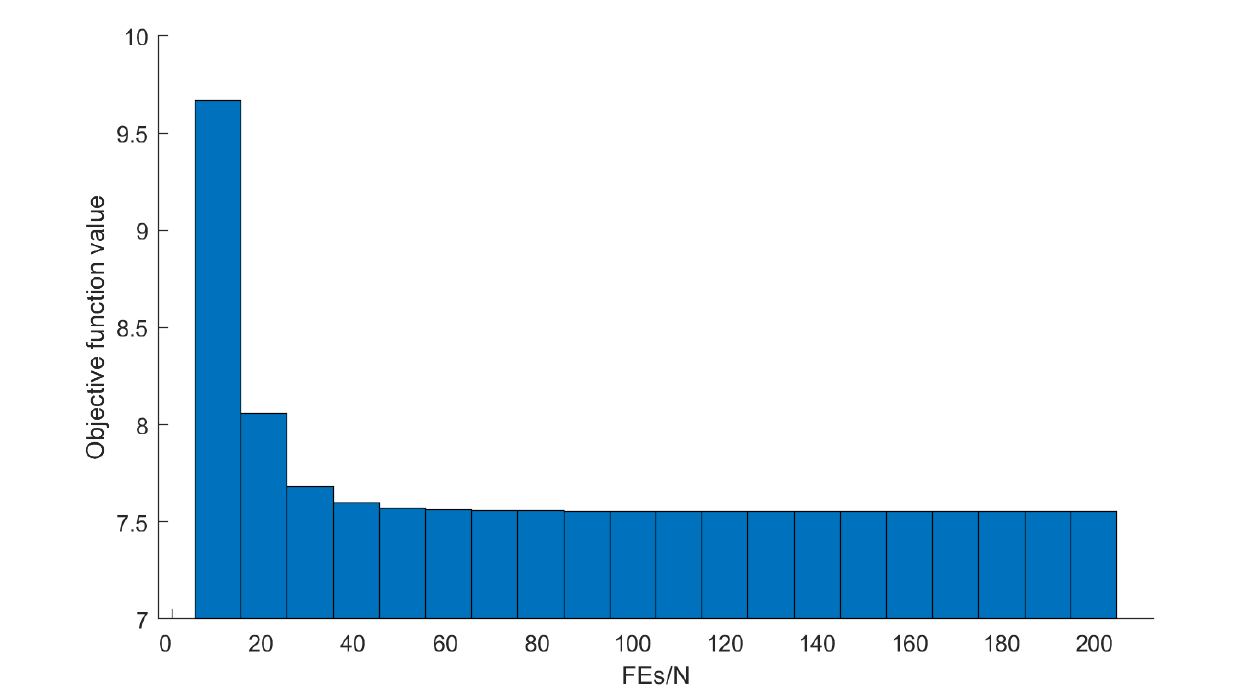
Figure 13. Convergence behavior of SMO. The horizontal axis denotes the number of fitness evaluations divided by N , which is the iteration times, and the vertical axis denotes the average objective